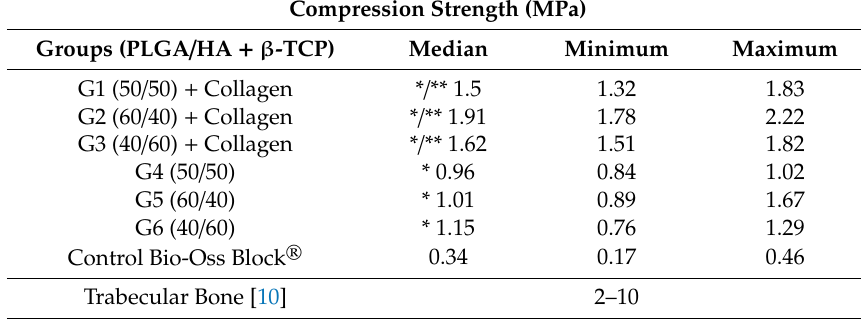
Table 3. Compressive strength values in the composite and control groups. There was a statistically significant di ff erence between the composites and control group. Moreover, statistical analysis revealed significant di ff erences in the compression strength between groups with (G1, G2, and G3) and without collagen impregnation (G4, G5, and G6).